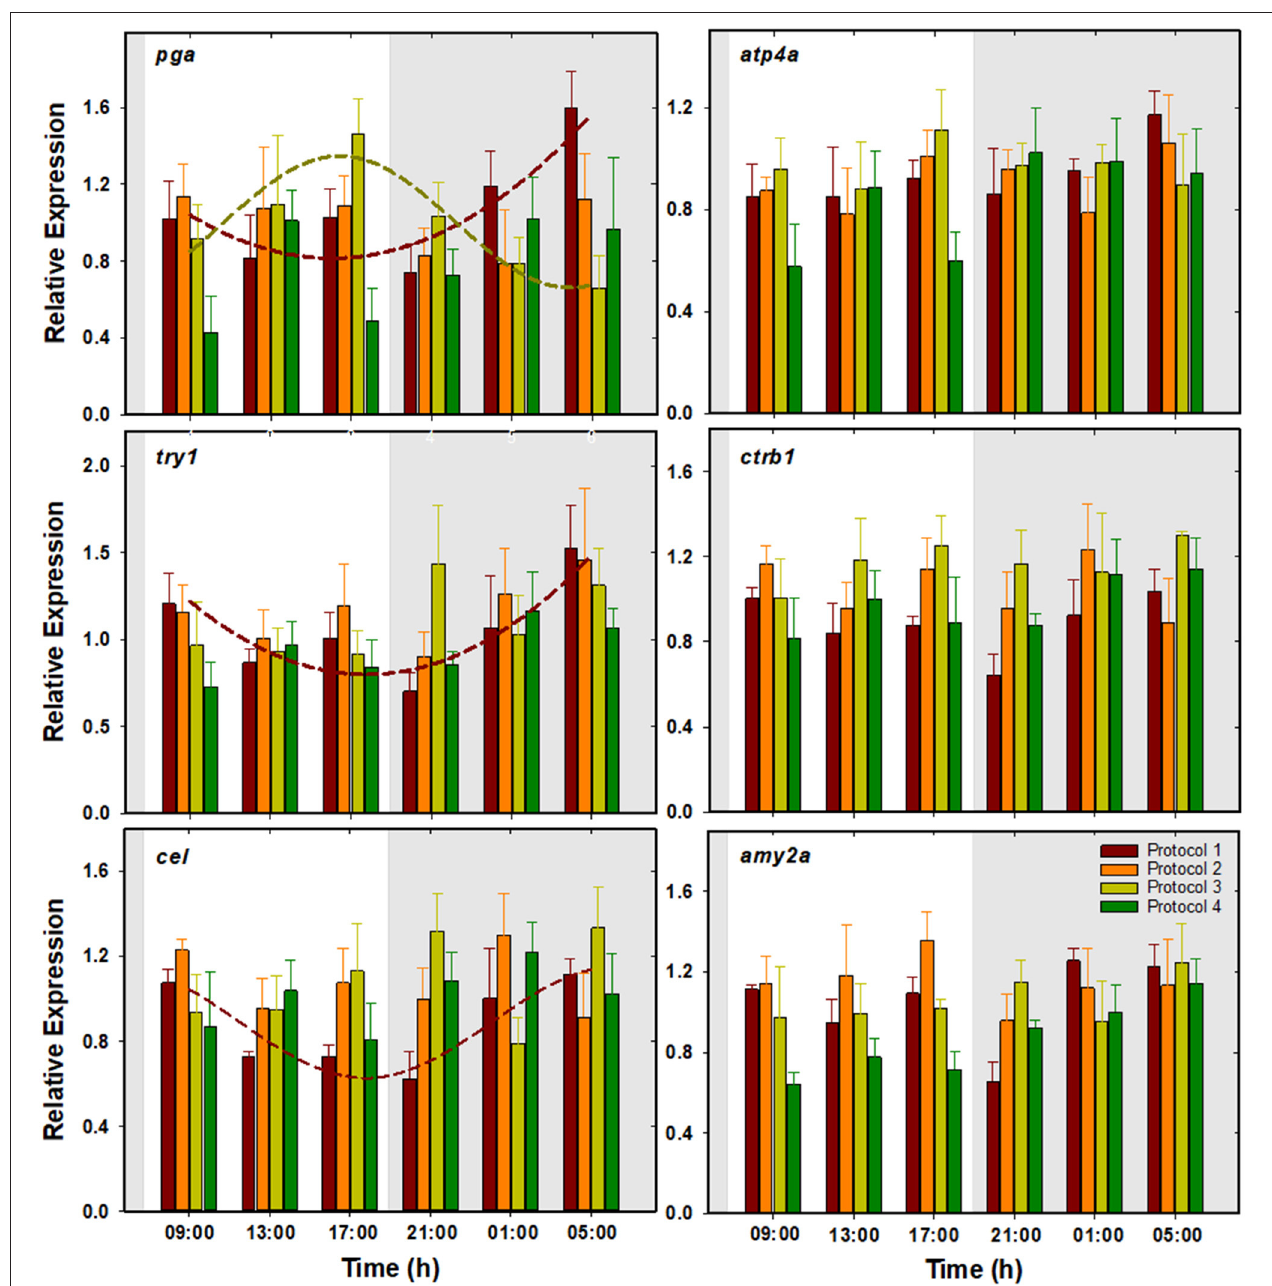
FIGURE 4 | Daily patterns of pga , atp4a , try1 , ctrb1 , cel , and amy2a expression in S. senegalensis with different feeding protocols. The rest of legend as in Figure 2 .